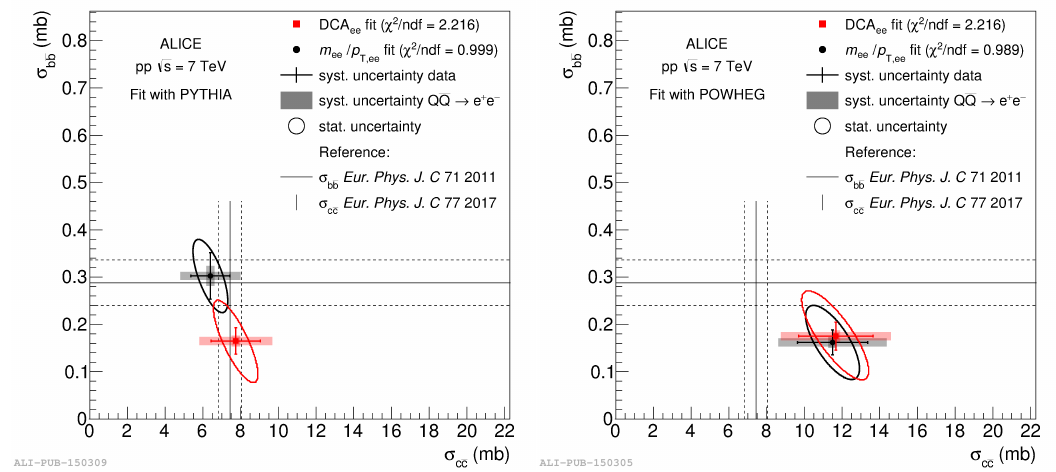
Figure 5. Total c¯c and b¯b cross sections with their systematic and statistical uncertainties, extracted from a fit of the measured dielectron yield from heavy-flavour hadron decays in ( m ee , p T,ee ) and in DCA ee with PYTHIA ( left ) and POWHEG ( right ) are compared to published cross sections (lines)